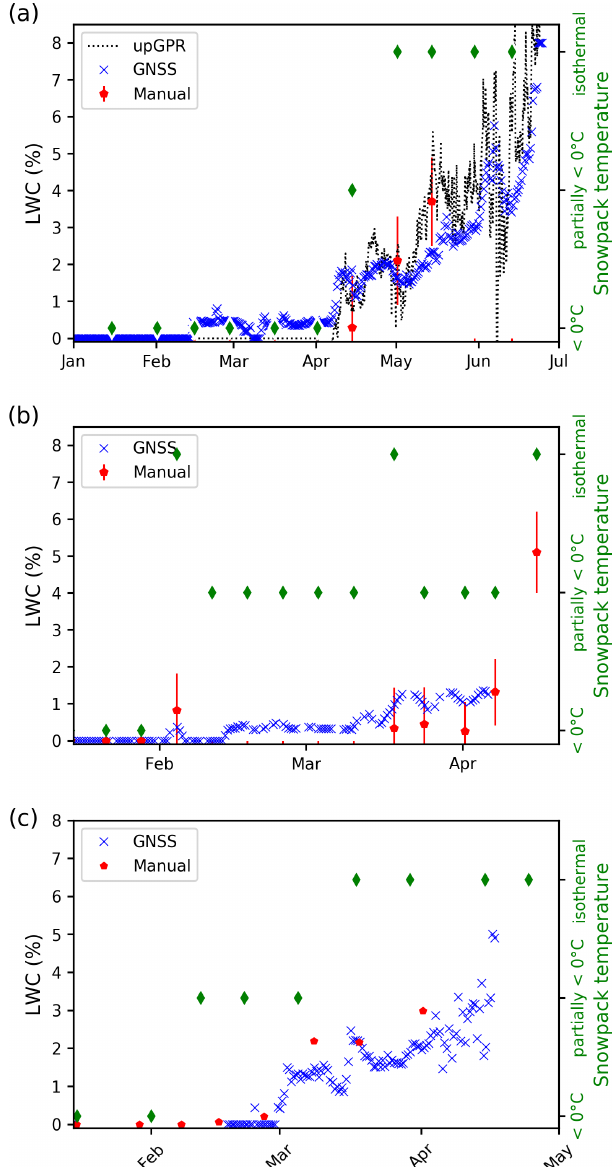
Figure 6. GNSS-derived LWC during the 2019–2020 winter for (a) Weissfluhjoch, (b) Laret and (c) Klosters in blue. The red points show the manually measured LWC (capacitive probe) averaged over the depth, and the vertical bars indicate the estimated error of the manually measured LWC. The green diamonds indicate the mean snowpack temperature. Only data points with HS > 5cm are shown.